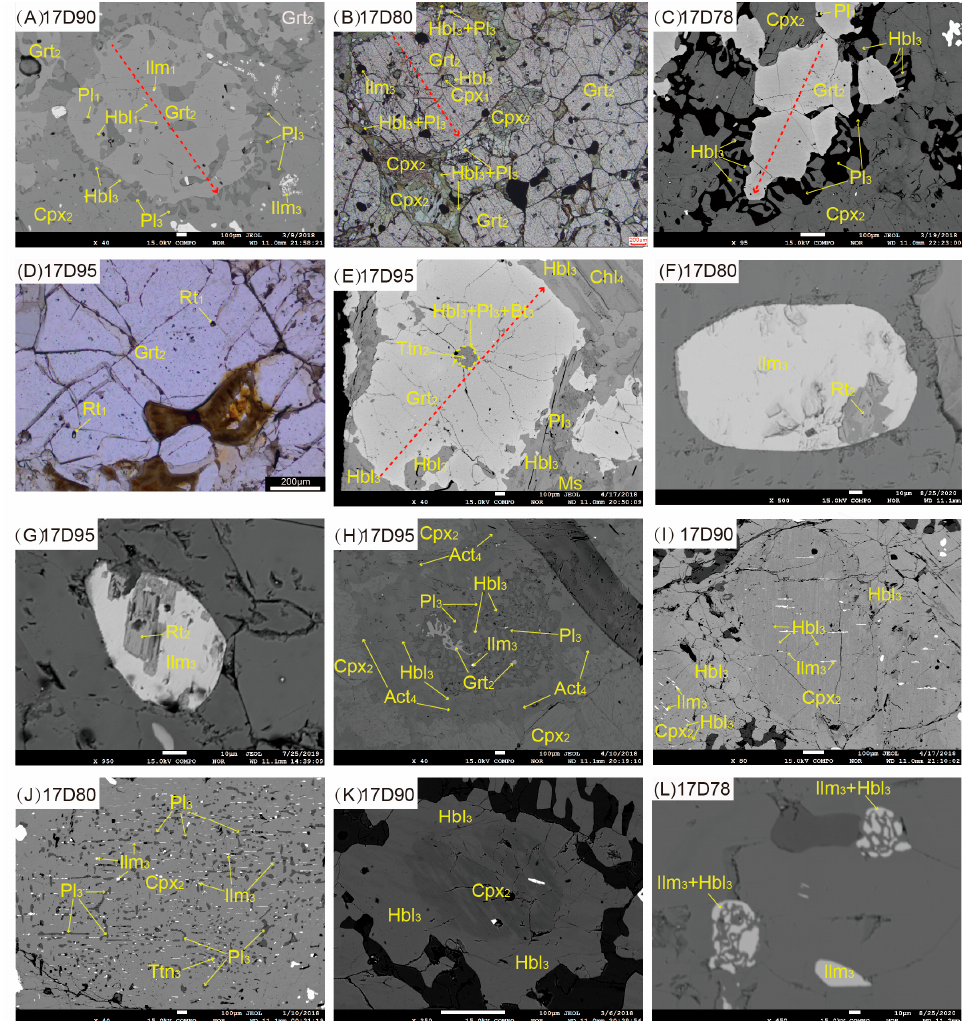
Figure 2. Micropetrography of the garnet clinopyroxenite. Subscripts 1, 2, 3, and 4 refer to the prograde (M1), metamorphic peak (M2), first retrograde (M3), and final retrograde (M4) minerals, respectively. The dashed red arrow refers to the electron microprobe analytical profile of garnet. Mineral abbreviations are after Whitney and Evans [24]. ( A ) The prograde assemblage (M1) is the tiny inclusions Pl 1 + Hbl 1 + Ilm 1 preserved in the garnet interior. The peak metamorphic assemblage (M2) consists of Grt 2 + Cpx 2 . The first retrograde assemblage (M3) is the symplectic Hbl 3 + Pl 3 intergrowth formed in between the matrix Grt 2 and Cpx 2 . ( B ) Besides the M1, M2, and M3 assemblages similar to that in (A), the Cpx 2 rim partially retrograded to Hbl 3 . ( C ) The symplectic assemblage (M3) Hbl 3 + Pl 3 formed between the matrix Grt 2 and Cpx 2 . ( D ) Rutile (Rt 1 ) inclusions enclosed in garnet (Grt 2 ). ( E ) The retrograde assemblage (M3) Hbl 3 + Pl 3 + Bt 3 formed both in the Grt 2 interior and in between the matrix Grt 2 and Cpx 2 , and the retrograde Chl 4 formed from the Hbl 3 rim. ( F ) Relict rutile (Rt 2 ) within Ilmenite (Ilm 3 ). ( G ) Most of the Rt 2 retrograded to Ilm 3 . ( H ) The Grt 2 was almost completely retrograded to Hbl 3 + Pl 3 , and Act 4 formed from the Hbl 3 rim. ( I ) The Hbl 3 and Ilm 3 lamellae (M3) exsolved from within the Cpx 2 . ( J ) The retrograde minerals Pl 3 , Ilm 3, and Ttn 3 lamellae (M3) exsolved from within the Cpx 2 . ( K ) The Cpx 2 rim retrograded to Hbl 3 . ( L ) Ilmenite (Ilm 3 ) + hornblende (Hbl 3 ) symplectite was possibly retrograded from rutile or high-Al titanite.